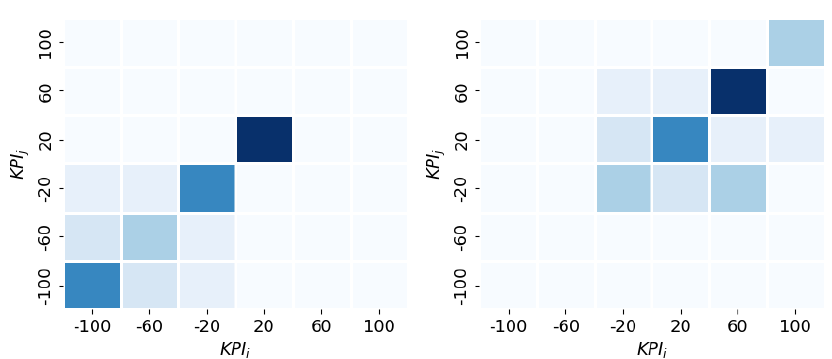
Figure 4. Two different stores represented as bivariate histograms. KPI values related to 𝐾𝑃𝐼 𝑖 and 𝐾𝑃𝐼 𝑗 are on the x-axis and y-axis, respectively, and each bin is colored by their relative frequencies.